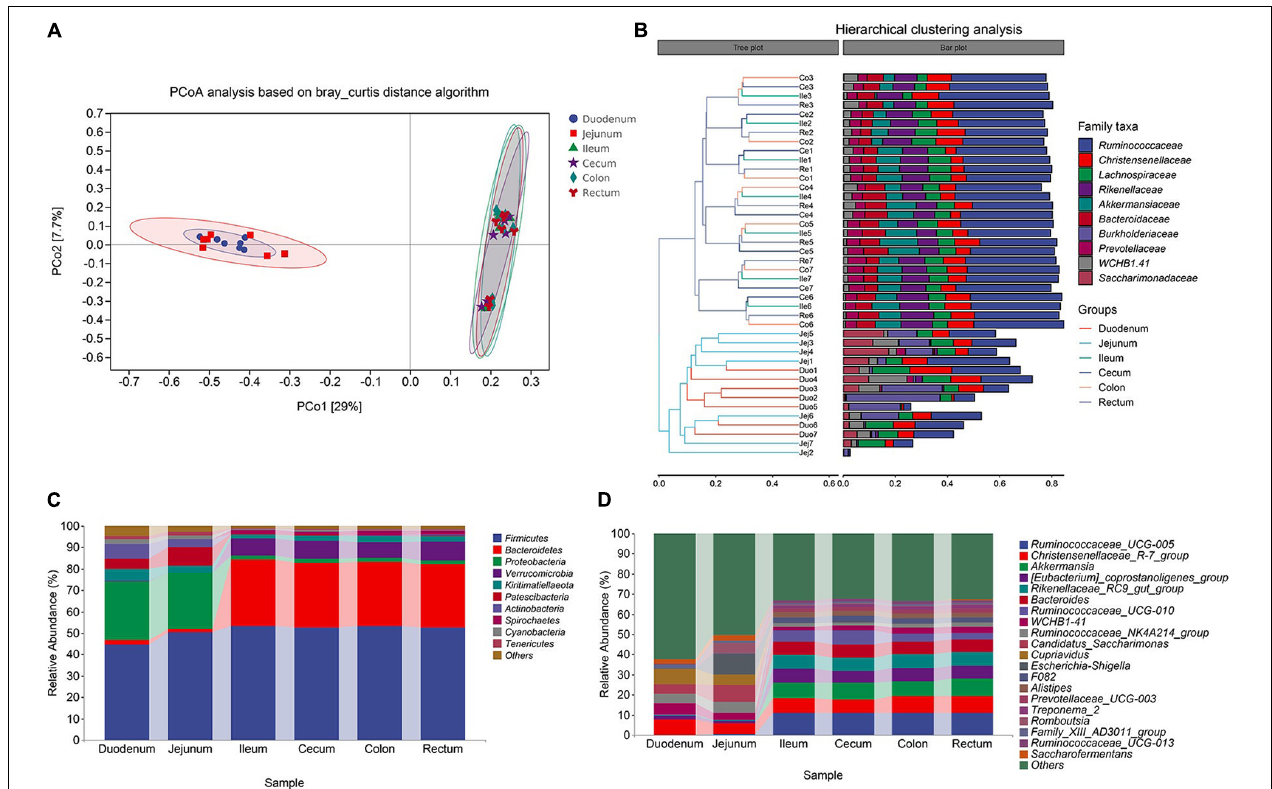
FIGURE 3 | Cluster analysis of Aohan fine-wool Sheep. (A) Principal coordinate analysis (PCoA) based on all samples. (B) The hierarchical tree shows the UPGMA clustering result. The abscissa indicates the distance between samples, the number after the group abbreviation represents the individual number, and the branch length indicates similarity. On the right is the stacked histogram of the top 10 abundant bacterial families in the sheep intestine. The abscissa indicates the proportion of bacteria. (C) The phylum-level microbial composition of each intestinal segment. (D) The genus-level microbial composition of each intestinal